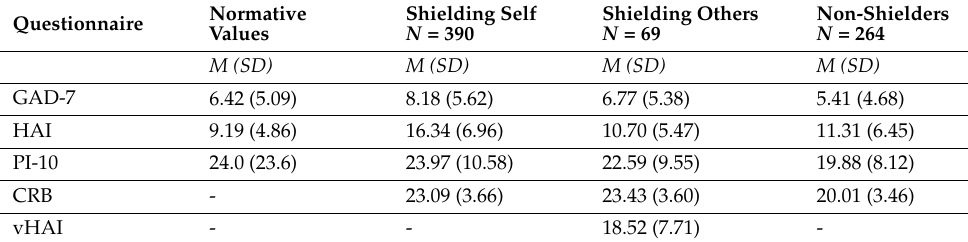
Table 4. Summary statistics for